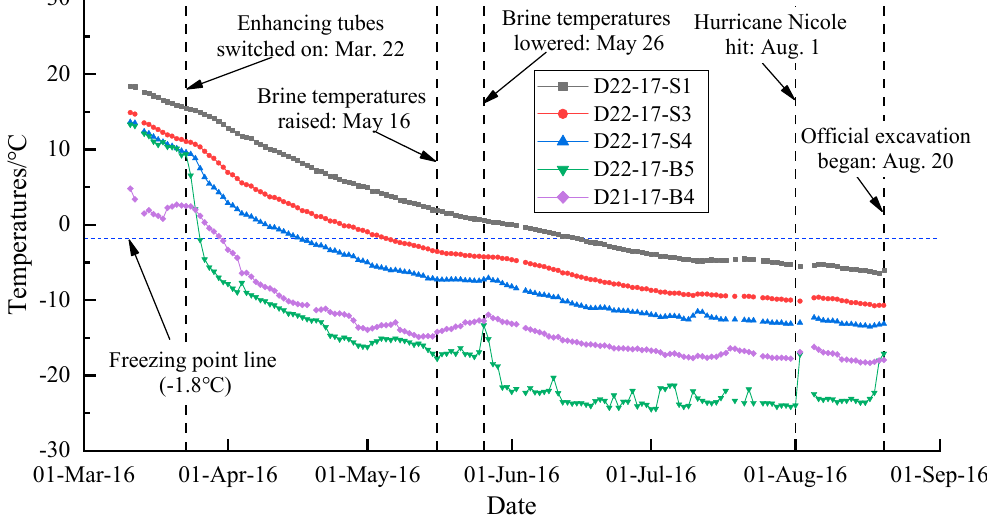
Figure 6. Temperature variation with time of measuring points at area A2 (see Figure 4).